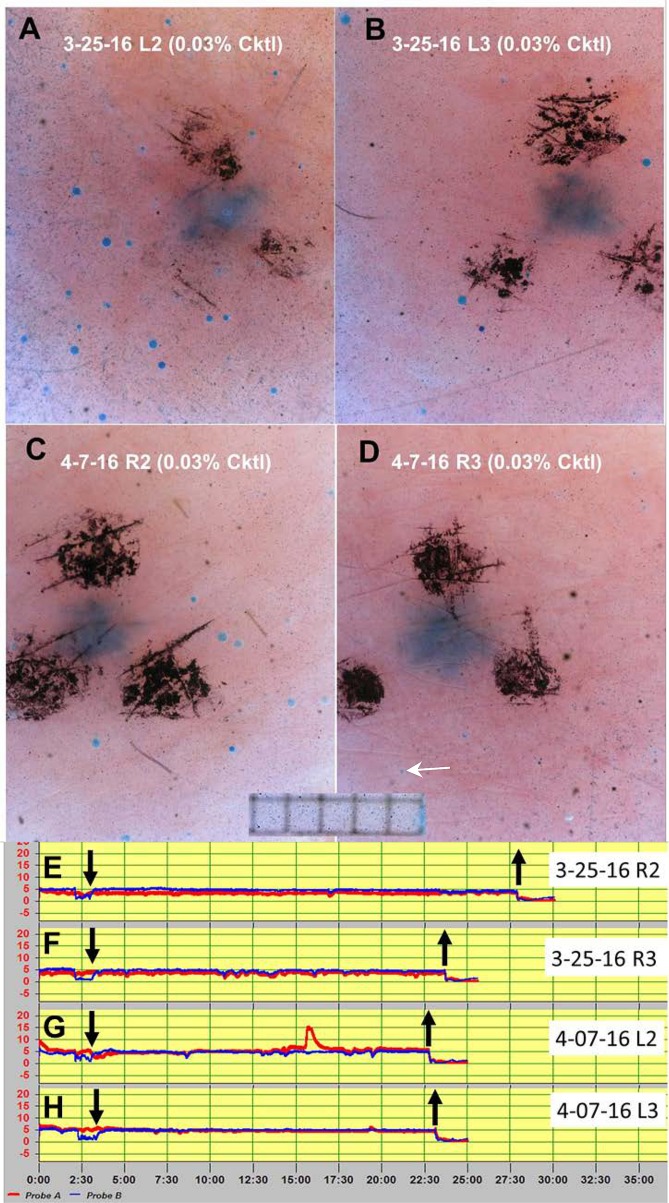
Responses to 0.03% cocktail in a CF carrier measured once at the same 4 sites with sweat bubble imaging and evaporimetry.(A-D) show sweat bubbles after 20 min of stimulation with 0.03% cocktail strength at each of the 4 sites (cropped images). (E-H) show evaporimetry traces to the 0.03% cocktail strength at each of the 4 sites. Down arrows show probes on and up arrows show probes off. Grid squares in (A-D) are 0.5 mm. Evaporimeter traces (E-H) show TEWL in units of 5 g/(m2·hr) on y-axis and units of 2.5 min on x-axis.